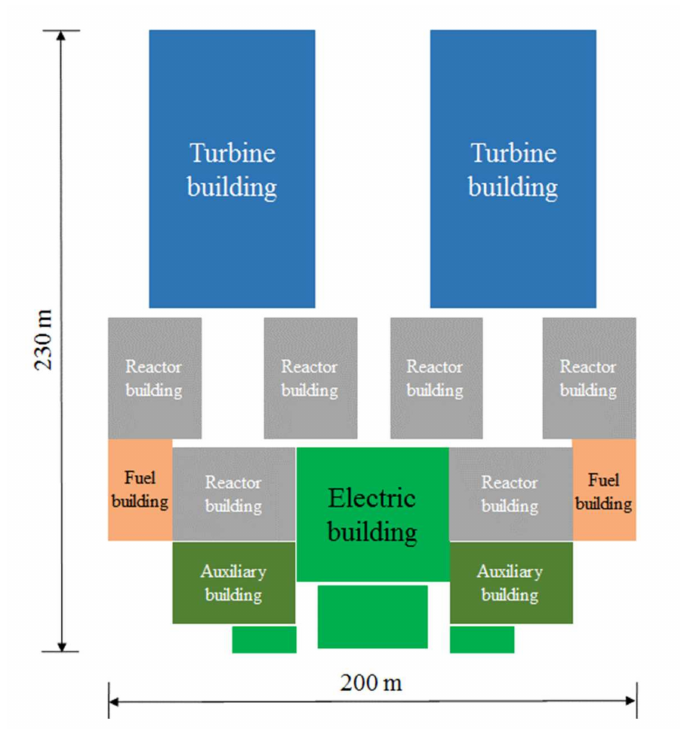
Figure 7. The 2 × 600 MWe HTR-PM multi-modules